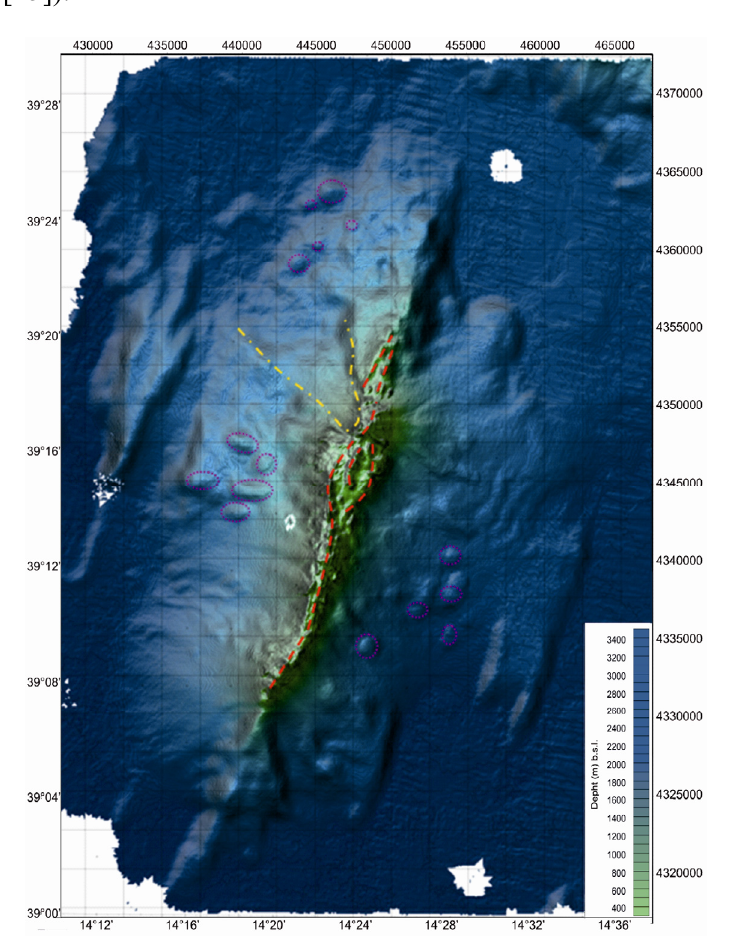
Figure 3. Detailed bathymetry of Marsili seamount. Red dashed lines: linear structures; violet dotted lines: main circular cones and terraces; yellow dashed line: major landslide (modified after